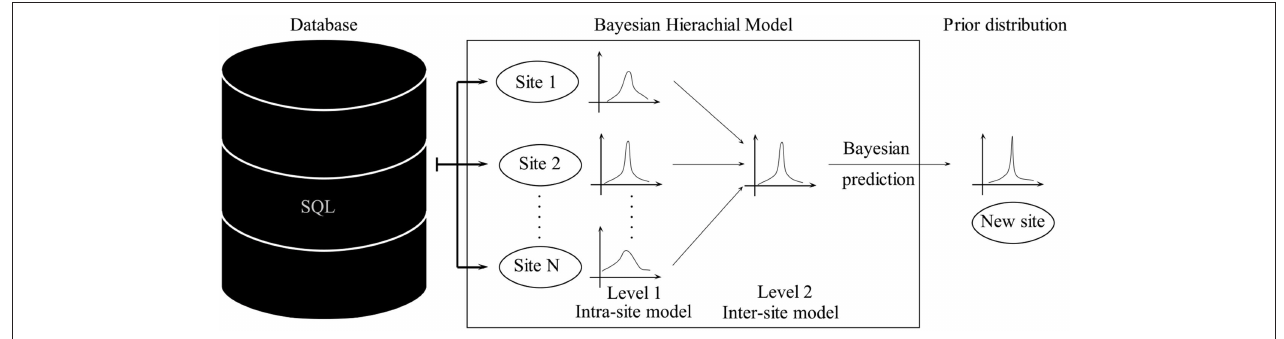
FIGURE 4 | Schematic of prior derivation using a Bayesian hierarchical